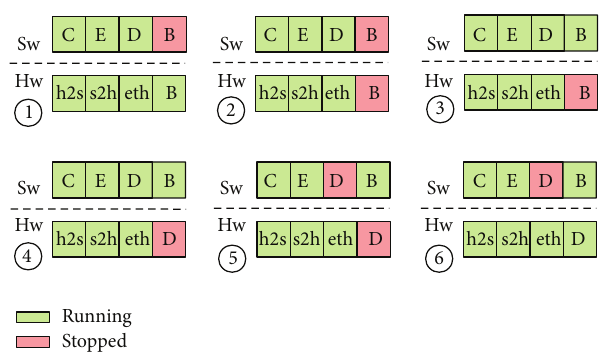
Figure 6: Dynamic hardware/software mapping.